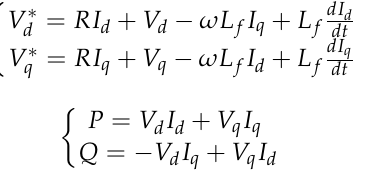
Figure 8. Model for VSC control. 3.5. Phase-Locked Loop PLL block must be added to the system since the conversion from the 𝑎𝑏𝑐 -frame to the 𝑑𝑞 -frame necessitates synchronization between the 𝑎𝑏𝑐 values and the 𝑑𝑞 values. It primarily comprises of a voltage-controlled oscillator, an output signal limiter, and a com- pensator [15–26]. The visual in Figure 9 brings to light the inner workings of a three-phase PLL using the Simulink model.